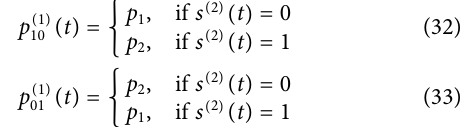
a symbolindicatesthatthelearningrate10 − 3 isforthecasewith4hiddenstates,whilethe learning rate [10 − 4 ] is for the case with 28 hidden states. This decrease of η is due to the increase in the dimensionality of the representation for the latter case in comparison to the situation where the read-out is composed by four concatenated values of activity. Furthermore,suchlearningratesare10timeshigherthanthecaseinwhichonlytheread- out is trained (only in the psMNIST task). Thus, the high learning rate adopted has the purpose to introduce noise in the learning process and to avoid local minima in the complex case where α and W out are optimised